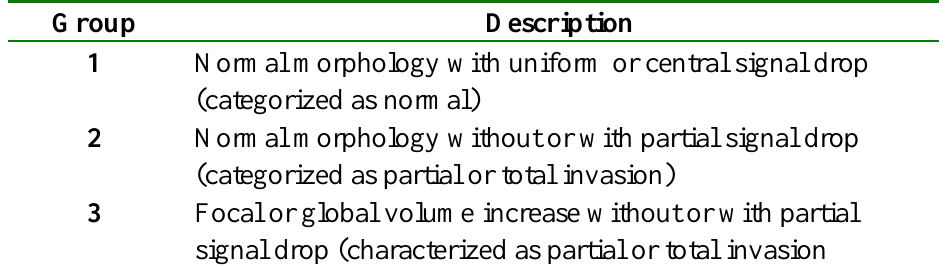
Table 1. Grading of node appearance on MRI following USPIO administration [26].